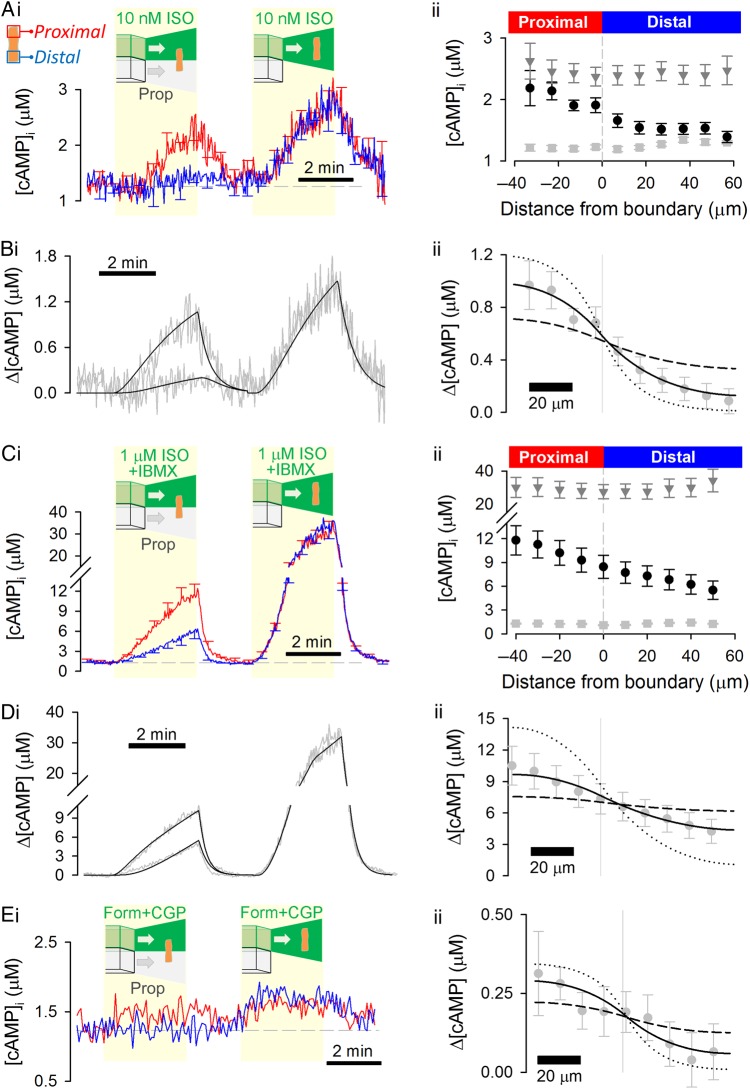
Cytoplasmic cAMP diffusivity is low, irrespective of the amount of cAMP produced or the type of β-receptor activated. (A) Experiment similar to that in Figure 1B repeated for lower (10 nM) dose of ISO (n = 15/4) to evoke a smaller proximal [cAMP]-rise. (B) Model fit to experimental data, with best-fit DcAMP = 32 ± 8.7 µm2/s confirming slow diffusion. (C) Experiment similar to that shown in Figure 1B repeated with phosphodiesterase inhibitor IBMX (100 µM) present in microstream containing 1 µM ISO (n = 12/4) to evoke a larger proximal [cAMP]-rise. (D) Mathematical model fit to experimental data, with best-fit DcAMP = 28 ± 3.0 µm2/s confirming slow diffusion. (D) Experiment similar to that in Figure 1B repeated using formoterol (100 nM) and CGP 20712A (1 µM) to selectively activate β2-receptors in the proximal end of the cell (n = 9/3). (i) The [cAMP]-rise was small, compared with the ISO response. A steady-state [cAMP] gradient can be resolved by time averaging over a 2-min interval during regional β2-adrenoceptor activation. (ii) Model fit to experimental data, with best-fit DcAMP = 24 ± 15.8 µm2/s confirming slow diffusivity. To illustrate the goodness-of-fit data, longitudinal profiles in Bii, Dii, and Eii were also simulated for a four-fold lower (dotted lines) and a four-fold higher (dashed lines) DcAMP.